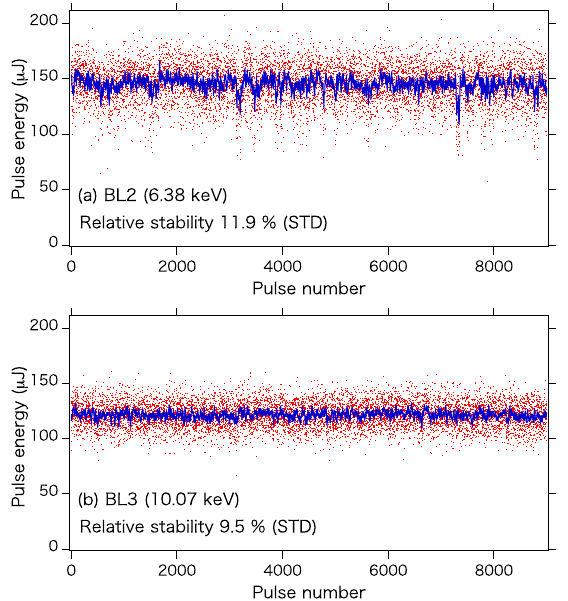
FIG. 9. Stability of the photon pulse intensity measured by an intensity monitor [21] in the multi-beam-line operation, (a) BL2 and (b) BL3. Red points represent single-shot results and blue lines show averaged values over 15 shots. The pulse repetition at each beam line was 15 Hz and the full horizontal scale corresponds to 10 minutes. The electron beam energy was 7.8 GeV and the undulator K-values were 2.85 and 2.1 for BL2 and BL3, respec- tively. The peak current is 1.2 kA for both beam lines.